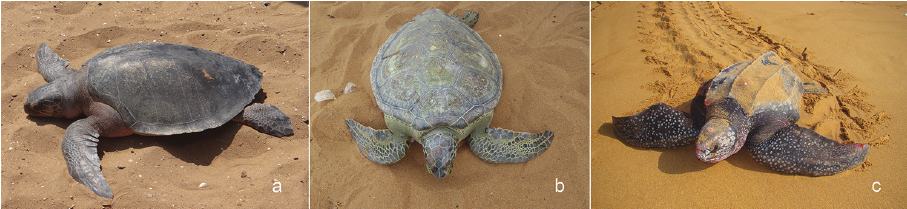
Figure 5. Sea turtle species considered in the survey: a Lepidochelys olivacea b Chelonia mydas c Dermo- chelys